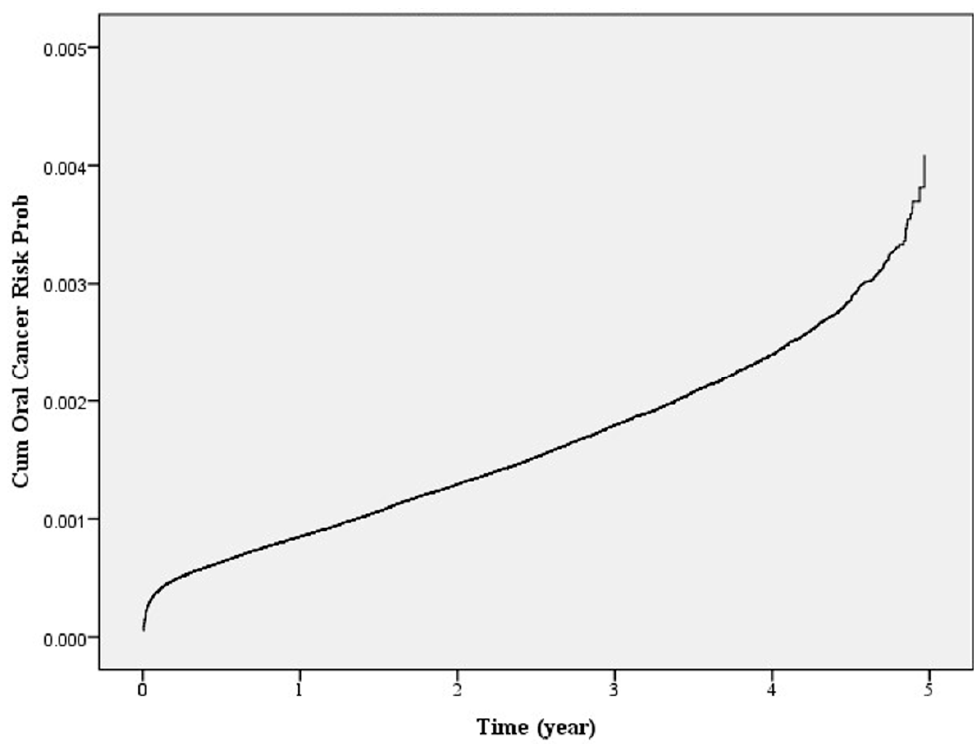
Figure 1. Risk of oral cancer in the high-risk population who had undergone oral cancer screening.